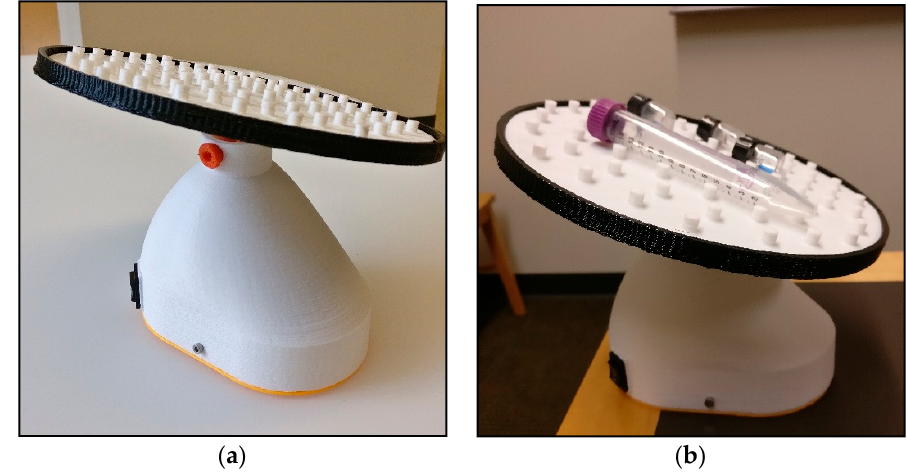
Figure 14. ( a ) Fully-assembld 3-D printed open source nutating mixer; ( b ) with samples of various sizes.